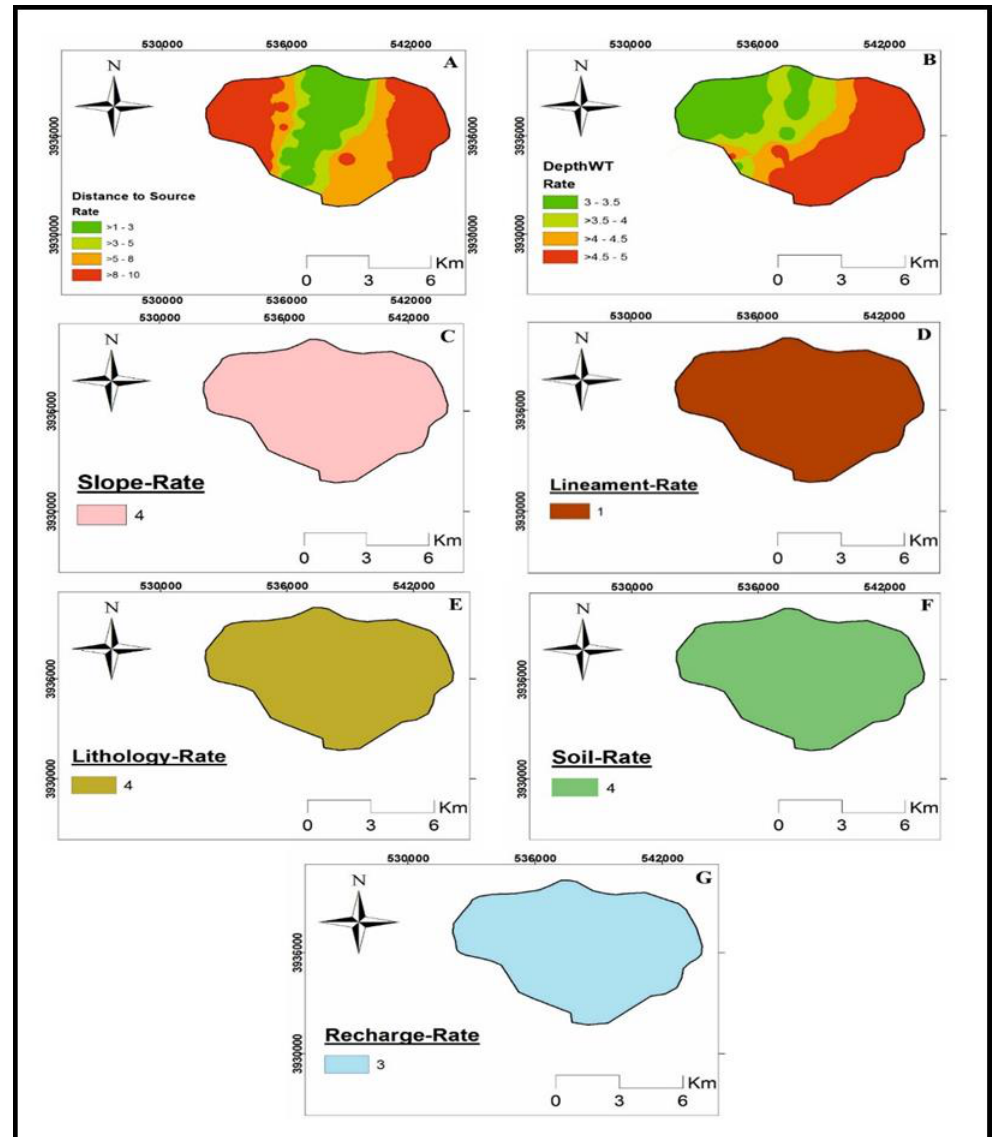
Figure 9. Seven rated maps for polluted risk intensity (PRI) map construction.